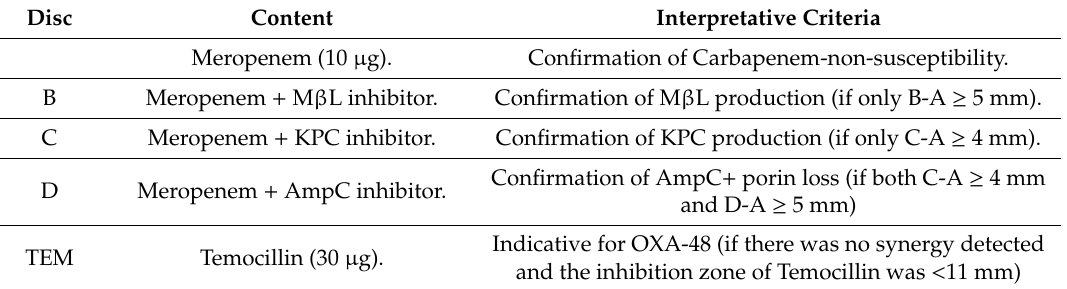
Table 3. The interpretative criteria of applied inhibitor-based